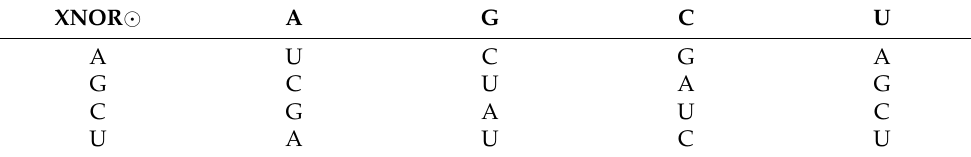
Table 8. RNA XNOR